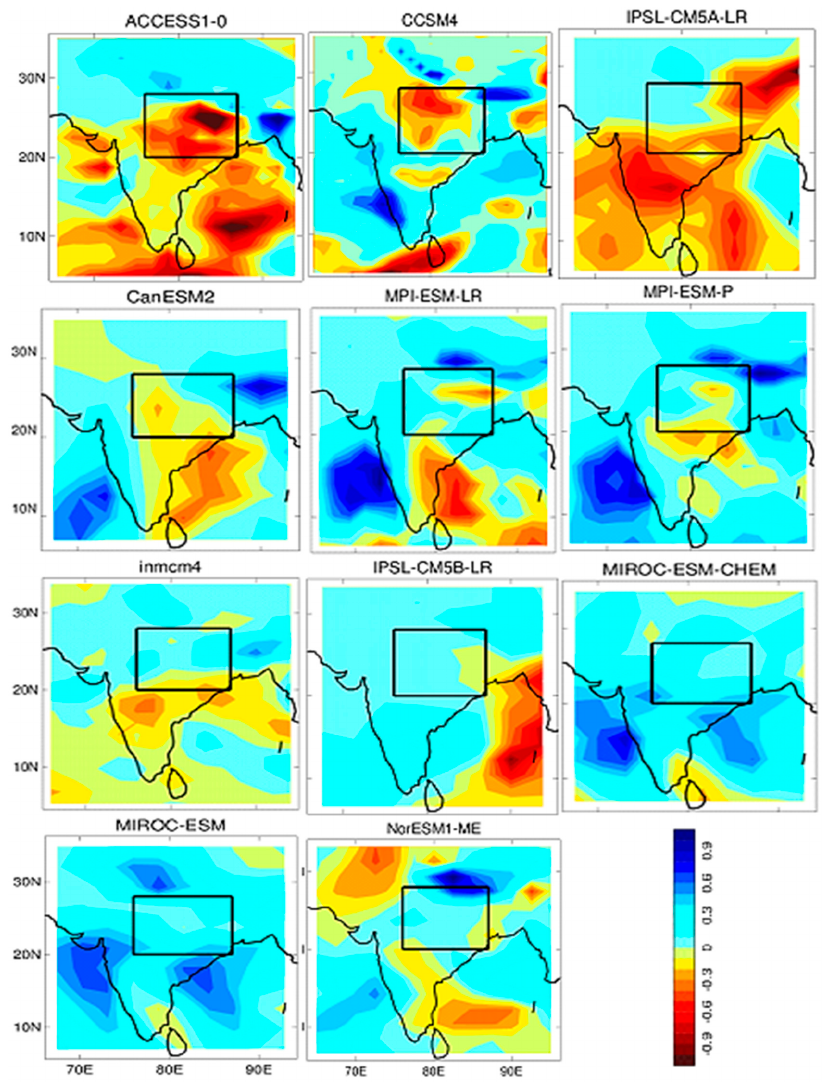
Figure 2. Spatial pattern of the Indian Summer Monsoon (ISM) precipitation (1940–2005) anomaly (mm/day) relative to a period (1985–2005) for various CMIP5 model outputs. CI region is marked by a rectangle.